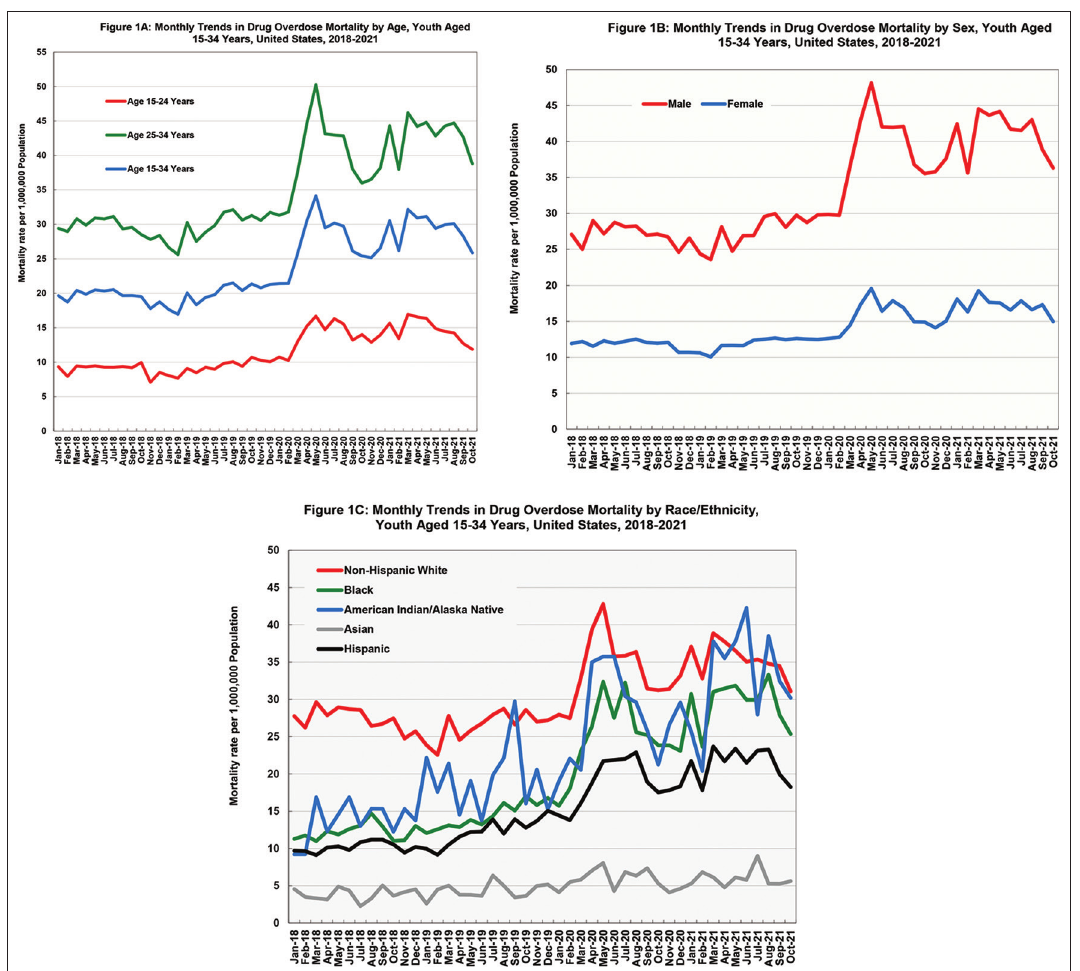
Figure 1 : (A-C) Monthly Drug Overdose Mortality Rates per 1 Million Population Among Youth Aged 15-34 years by Age, Sex, and Race/Ethnicity, United States, January 2018 through October